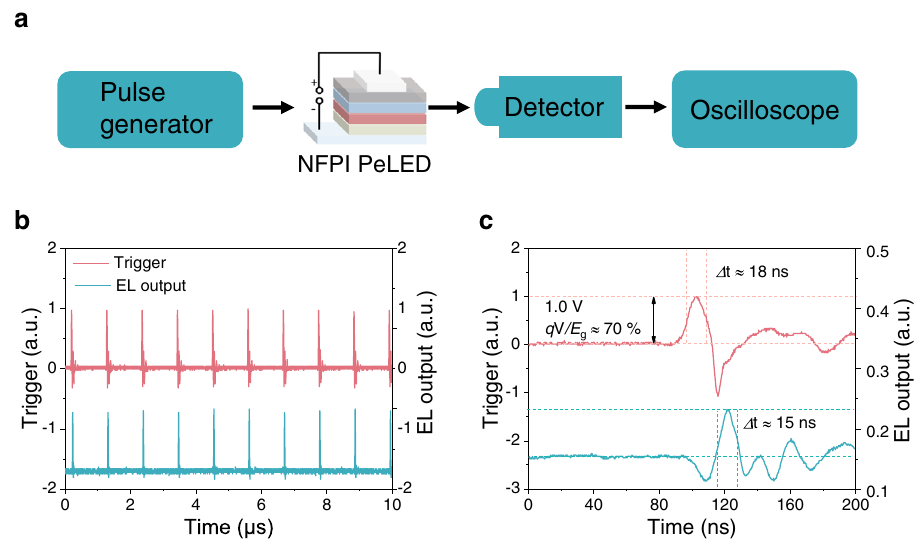
Fig. 6 Optical pulse generation from a perovskite LED under ultralow voltages. a Schematic diagram of a simple optical communications setup featuring an NFPI perovskite LED. b Characteristics of the voltage triggers from the pulse generator at a peak voltage of 1.0 V (0.65 E g / q ) at 1 MHz and a sampling rate of 10 μ s/div, and the corresponding optical pulses (EL output) from the perovskite LEDs. c One of input voltage triggers from the pulse generator at a sampling rate of 40 ns/div, and the corresponding EL output from the perovskite